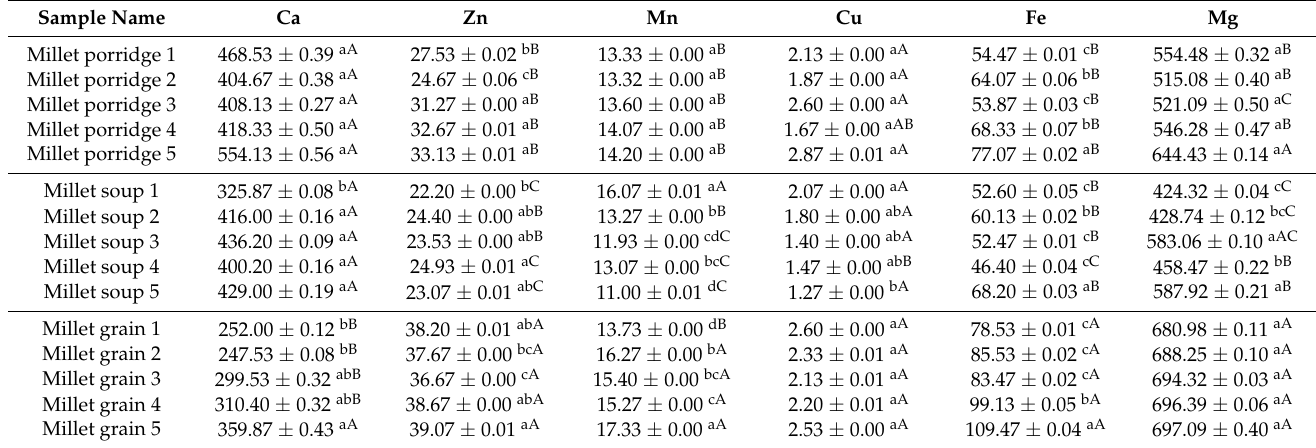
Table 6. Mineral content in millet porridge cooked in different electric